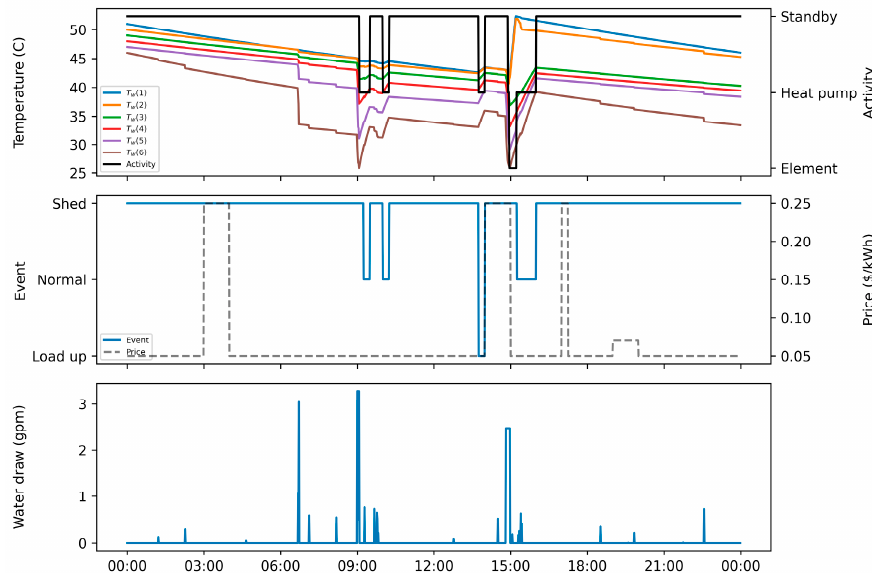
Figure 7. Baseline operation.